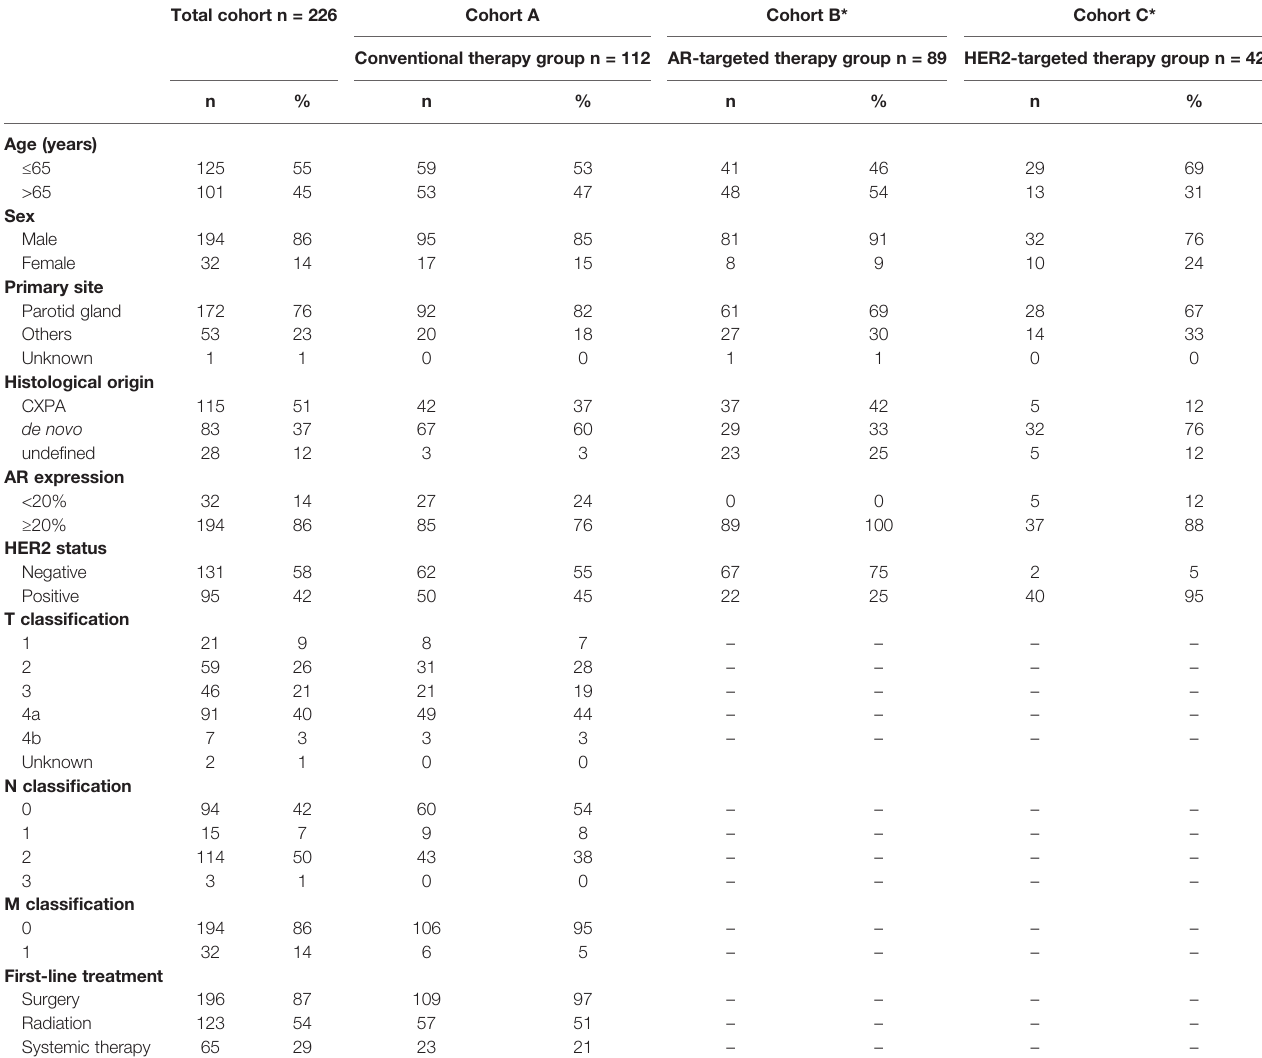
TABLE 1 | Patients ’